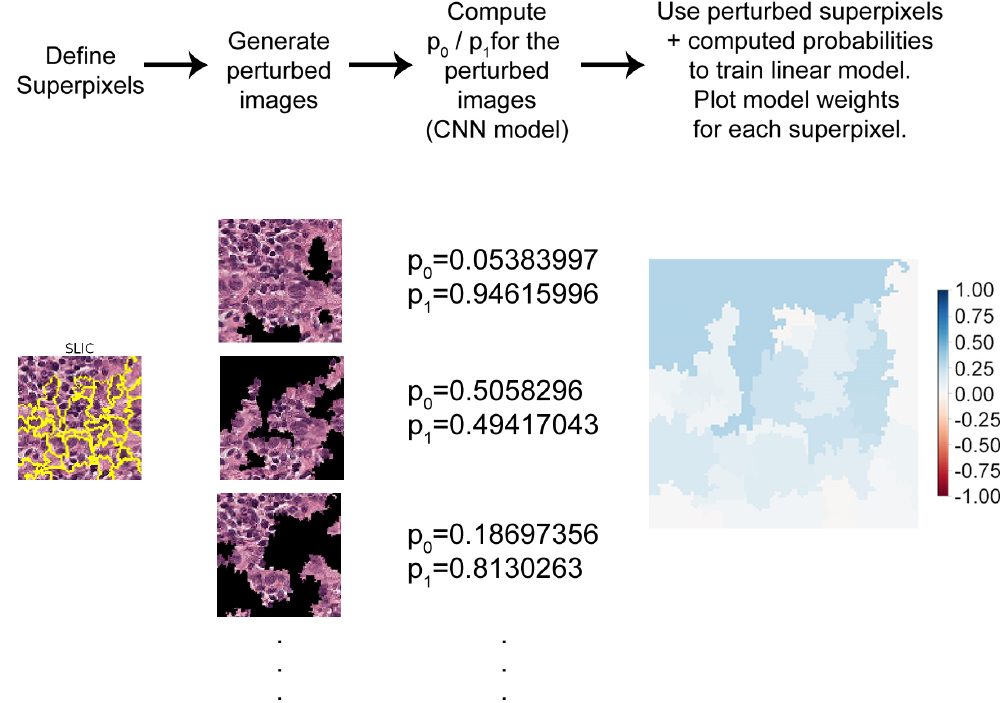
Figure 2. Diagram of the Locally-Interpretable Model-agnostic Explanations (LIME) algorithm in